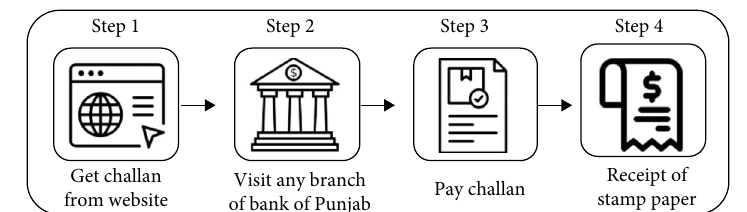
Figure 4: Fee paying process.